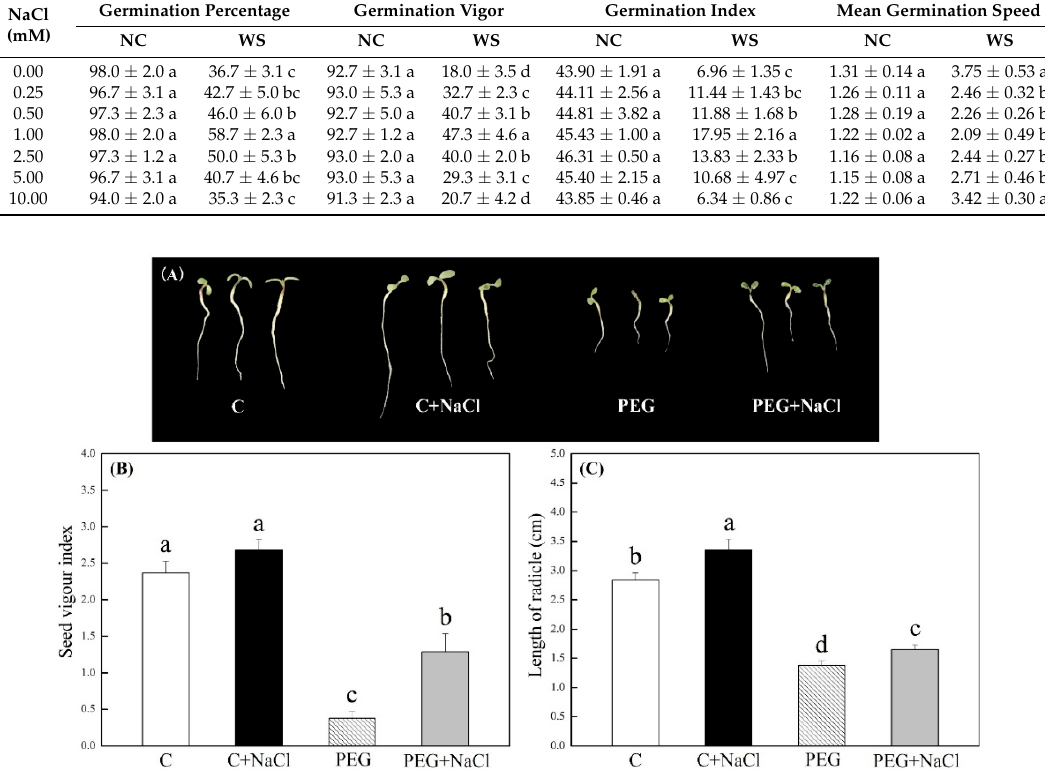
Figure 1. Effects of seeds soaking with water or NaCl (1 mM) on ( A ) phenotypic change, ( B ) seed vigor index (VI), and ( C ) length of radical after seven days of germination under normal condition and water stress induced by 19% polyethylene glycol (PEG) 6000. Vertical bars indicate the ± SE of mean ( n = 6). Different letters above columns indicate significant difference ( p ≤ 0.05).